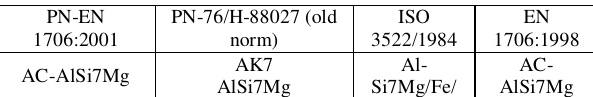
Table 2. Designation of aluminum alloys castings according to selected standards [10]